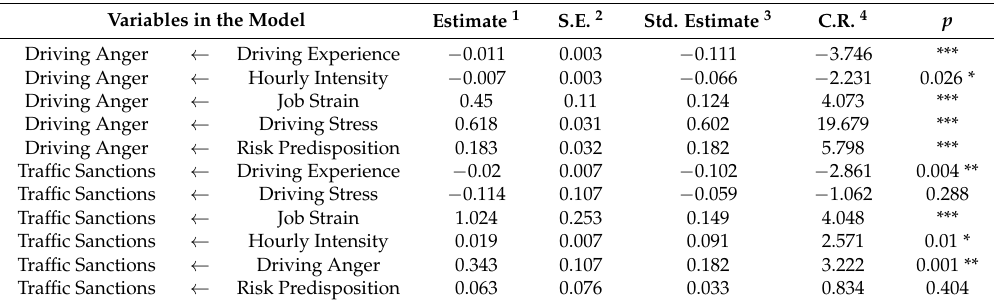
Table 2. Structural equation model (SEM) to predict traffic sanctions (two years) with driving anger as the mediating